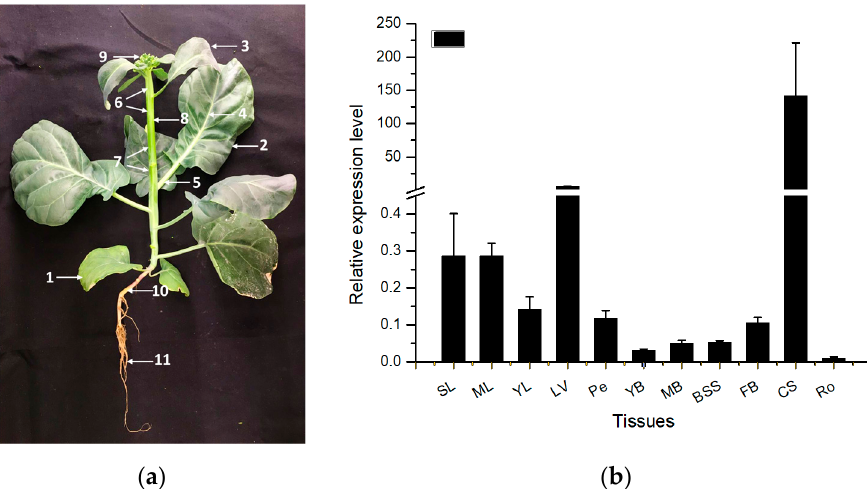
Figure 4. The expression pattern of BocMBF1c in different tissues under standard growth conditions. ( a ) Various tissues of Chinese kale. SL, senescent leaf; ML, mature leaf; YL, young leaf; LV, leaf vein; Pe, petiole; YB, young bolting stem flesh; MB, middle bolting stem flesh; BSS, bolting stem skin; FB, flower buds; CS, combining sites between stem and root; Ro, Roots. ( b ) Bolting stage tissues were harvested for expression specificity analysis. Quantitative PCR (qPCR) was used to measure BocMBF1c expression in different tissues, with the BocTubulin8 gene as the control. Data shown are the mean ± SD of three biological